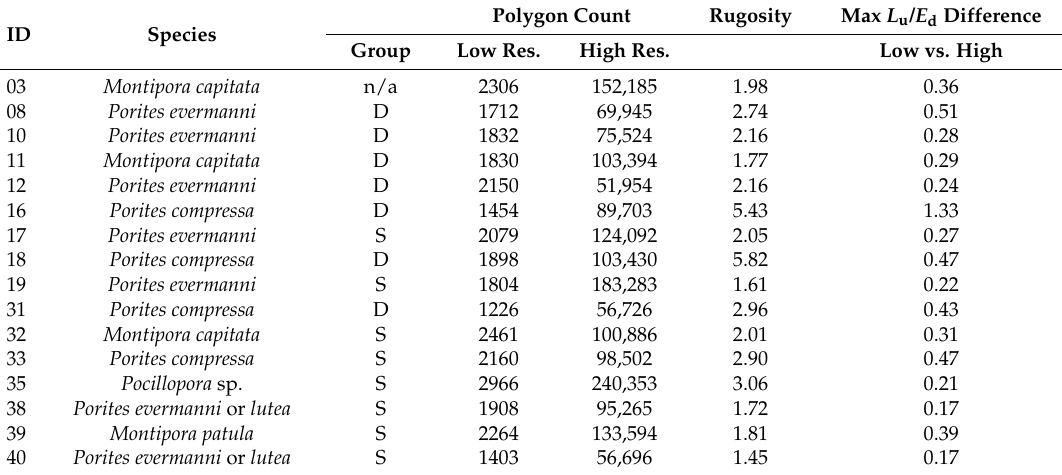
Table 2. Coral shapes used in this study. “Group” indicates grouping based on depth of collection, shallow (S, <8 m) or deep (D, 10–20 m). Coral 03 was from a site subjected to terrestrial run-off and was not placed in either group. Polygon counts for the high- and low-resolution models are given. The final column is discussed in the results and is the maximum percentage difference that choice of resolution leads to in reflectance averaged over the coral area in any